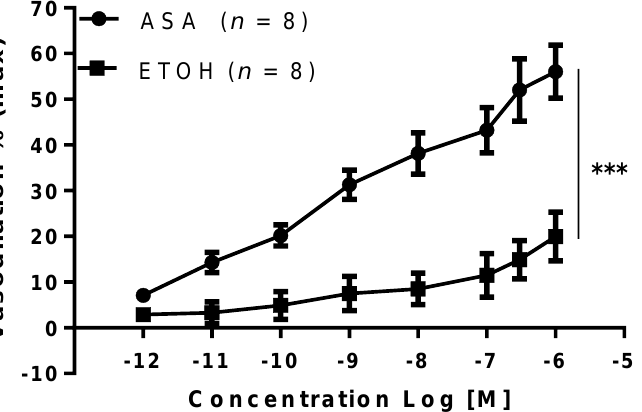
Figure 1. Acetylsalicylic acid vasodilation on mesenteric arteries. Acetylsalicylic acid (ASA) and its vehicle ethanol (ETOH) were tested on phenylephrine preconstricted mesenteric arteries isolated from gravid rats. Data are reported as mean ± SEM, n = number of experiments, *** p < 0.001 (two-way ANOVA).